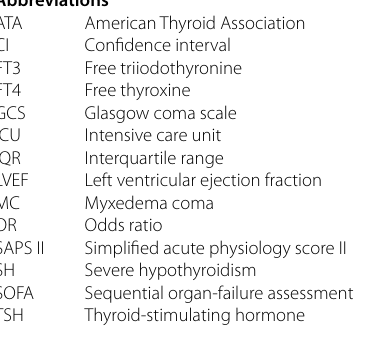
Additional file 1: Figure S1. Flowchart of patient selection from participating ICUs. Table S1. Amount of Missing Data for Each Variable Included in the Analysis. Table S2. Characteristics of Severe Hypothyroid‑ ism Patients According to the Presence of a Circulatory Failure at ICU Admission. Table S3. Clinical and Biological Features at ICU Admission according to ICU survival. Table S4. Predictive Patient Factors Associated with 6‑month Mortality in Critically ill Adults with Severe